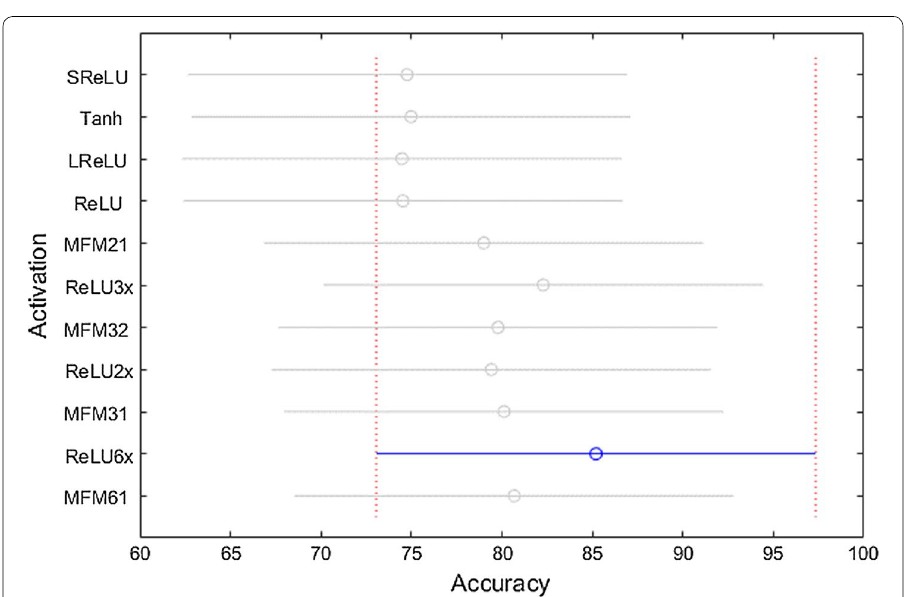
Fig. 11 Multiple comparisons, activations on image